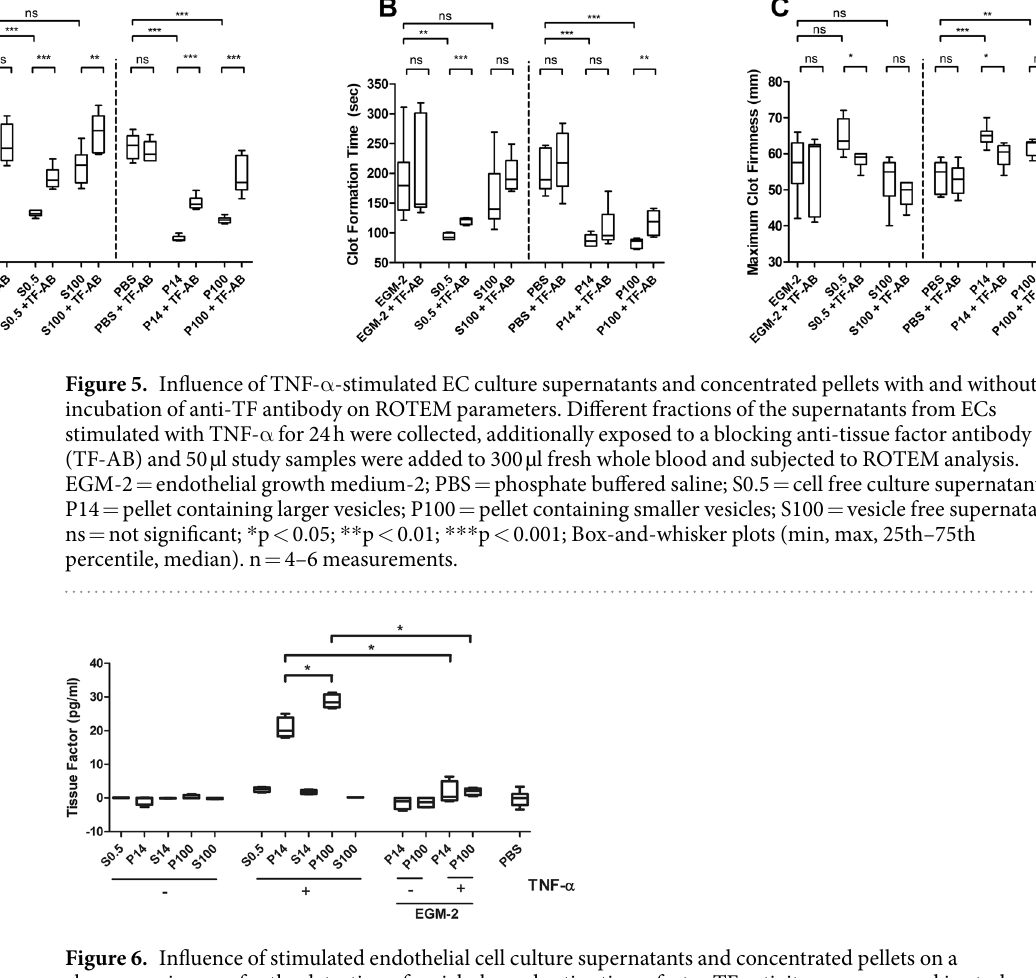
Figure 6. Influence of stimulated endothelial cell culture supernatants and concentrated pellets on a chromogenic assay for the detection of vesicle-bound active tissue factor TF activity was measured in study samples. Supernatants from ECs from at least two different donors that were stimulated with TNF- α for 24 h were collected and subjected to centrifugation steps as illustrated in Fig. 1. PBS = phosphate buffered saline; EGM-2 = endothelial cell growth media-2; S0.5 = cell free culture supernatant; P14 = pellet containing larger vesicles; P100 = pellet containing smaller vesicles; S100 = vesicle free supernatant; Box-and-whisker plots (min, max, 25th–75th percentile, median); * p <